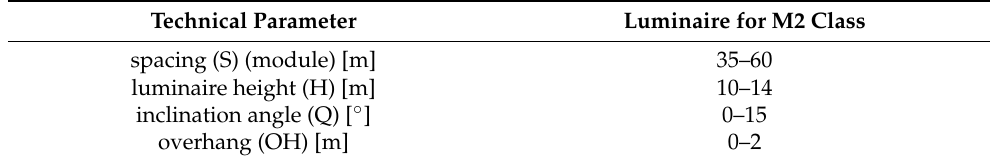
Table 7. The analysis of the effect of the photometric distance of single LEDs on the results of light- ing installation projects.